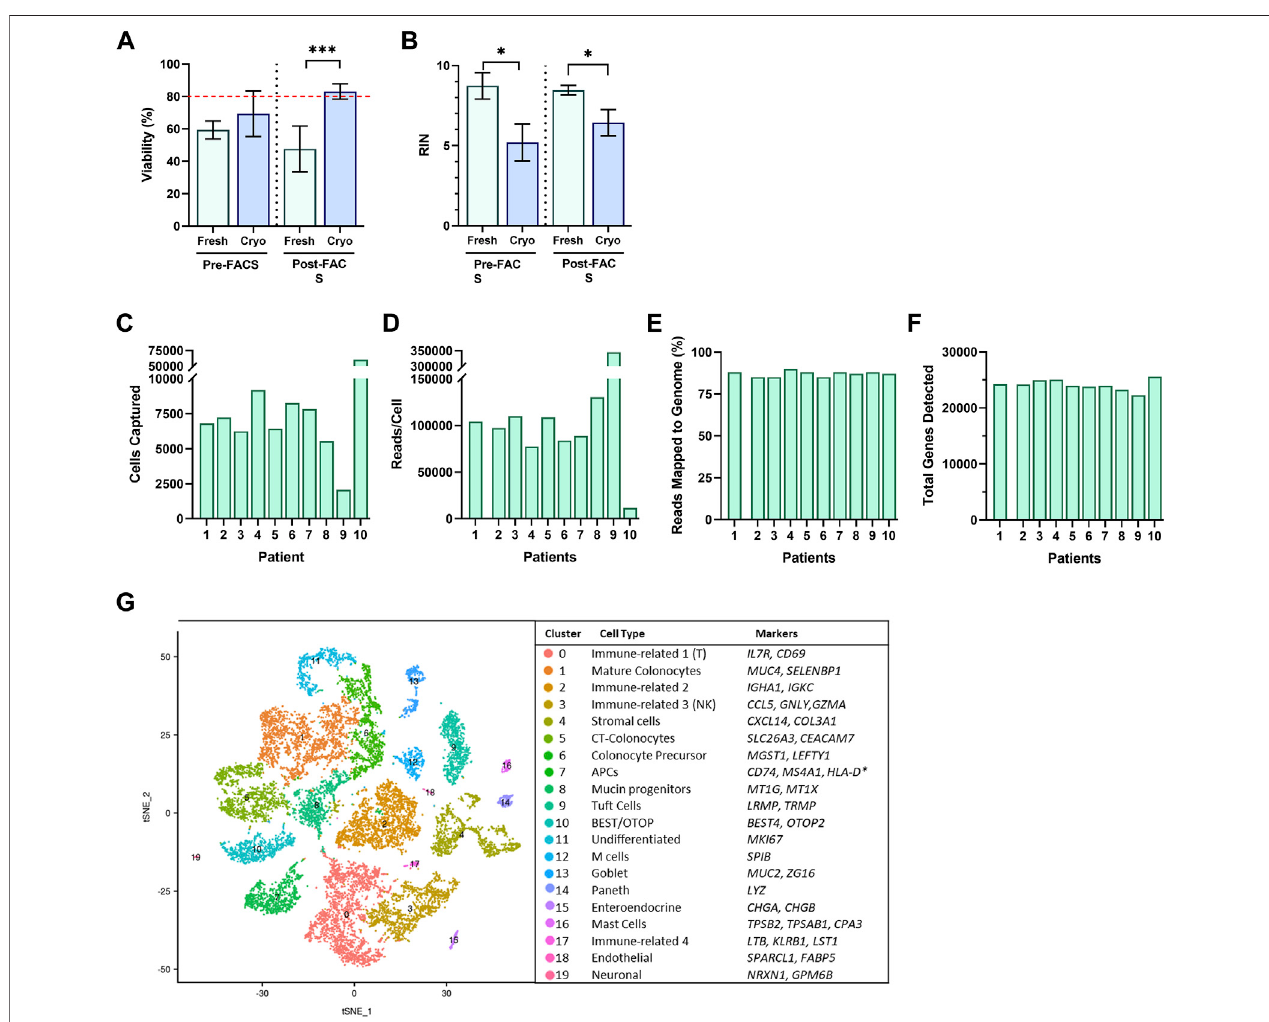
FIGURE3| Singlecellssuspensionswereassessedfor (A) cellviabilityand (B) RNAIntegrityNumber(RIN)fromfresh(green; n =3,2,forpre/postrespectively)and cryopreserved (blue; n = 3, 10, for pre/post respectively)tissue preparations during Pre-FACS isolation and 1-h Post-FACS isolation. Summary ofData Generation from scRNA-Sequencingof FACS-isolated Human Colonic Epithelial Cells Originating from Cryopreserved Biopsies of10participants for (C) cell captured, (D) reads/cell, (E) reads mapped to genome (%), and (F) total genes detected. (G) Single-Cell RNA-Seq Pro fi ling of Human Colonic Epithelium. t-SNE plots of single-cell RNA-seq pro fi les of human intestinal epithelial cells, colored by cluster number and identity, listed by largest to smallest population, and annotated by cluster identity, determined by gene markers for subtypes. Signi fi cance testing used a two-tailed student t-test; * p < 0.05, *** p < 0.001.